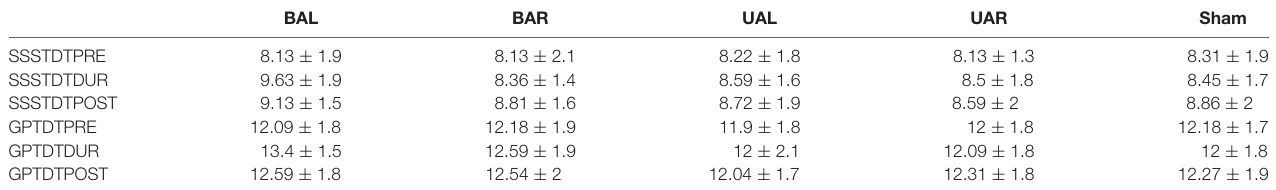
TABLE 2 | Dual-task (DT) performance: number of pegs inserted (GPT) and number of correct subtractions (SSST) within 30 s before (PRE), during (DUR) and 30 min after (POST), unilateral (Ul), bilateral (Bl) and sham tDCS of left (AL) and right (AR) DLPFC.